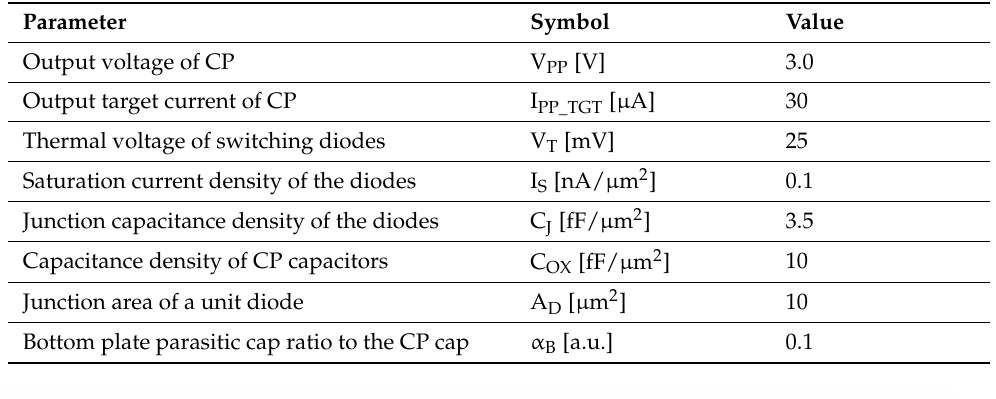
Table 2. Design and device parameters for demonstration.